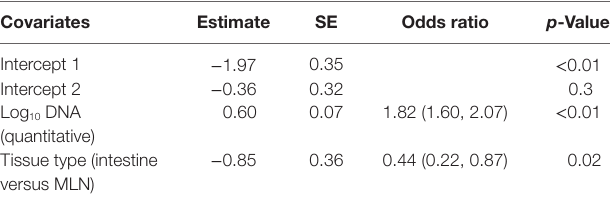
TaBle 4 | Result of ordinal logistic regression with ordinal histopathological lesion score as response and log 10 DNA quantified in the quantitative PCR of tissues and types of tissues [intestine and mesenteric lymph node (MLN)] as predictors. covariates